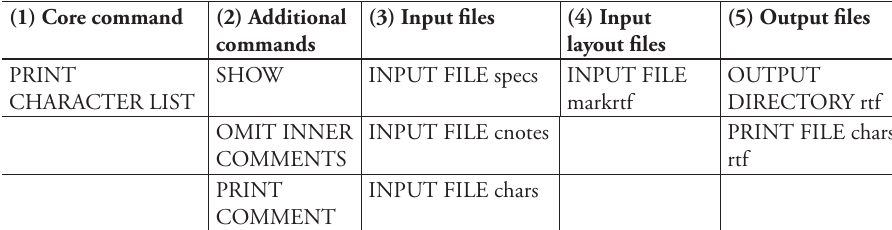
Figure 28. Directive fi le printcr for the output of characters used in a DELTA database. Th e numbers to the left of the directive fi le indicate diff erent classes of directives (see in Table 1). Table 1. Classifi cation of commands used in the printcr directive fi le. Reference numbers used in Fig. 28 are given in the header of the